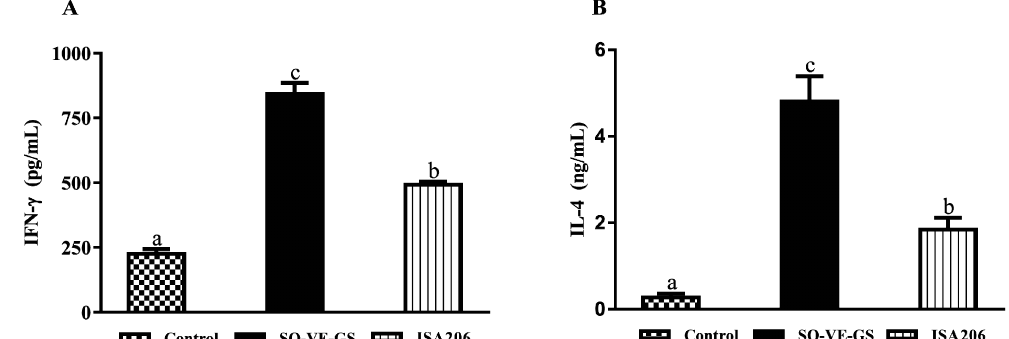
Figure 2. Serum IFN- γ and IL-4. Hu sheep were i.m. immunized twice at a 3-week interval with FMD vaccine emulsified with SO-VE-GS (n = 10) or ISA 206 (n = 9), and sheep without immunization served as a control (n = 10). Blood samples were collected at 8 weeks post the booster for analysis of IFN- γ ( A ) and IL-4 ( B ). The values are presented as mean ± SE. Bars with different letters are statistically different ( P < 0.05).